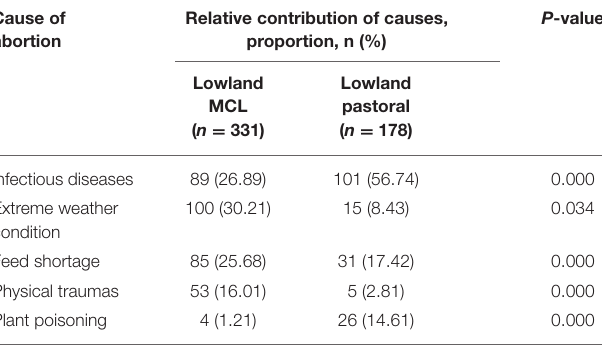
TABLE 3 | Perceived causes of sheep and goat abortion in lowland MCL and pastoral agroecology and production system in Ethiopia. Cause of Relative contribution of causes, abortion proportion, n (%)